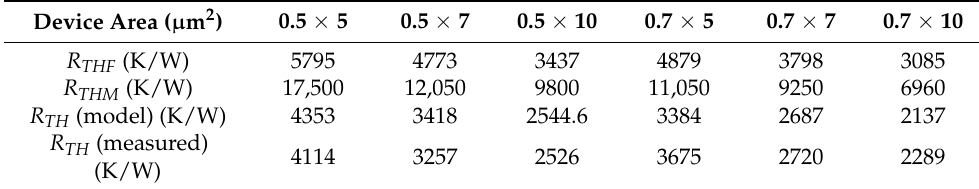
Table 2. Thermal resistances extracted from the thermal impedance model and